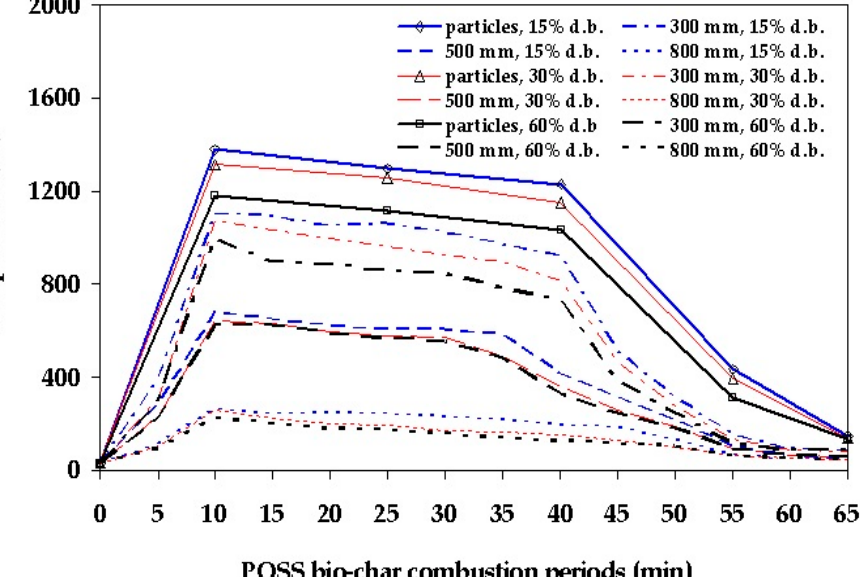
Figure 4. The temperature under condition of 0.1 m/s clean air speed, and different distance locations above the base of the fire and moisture content .